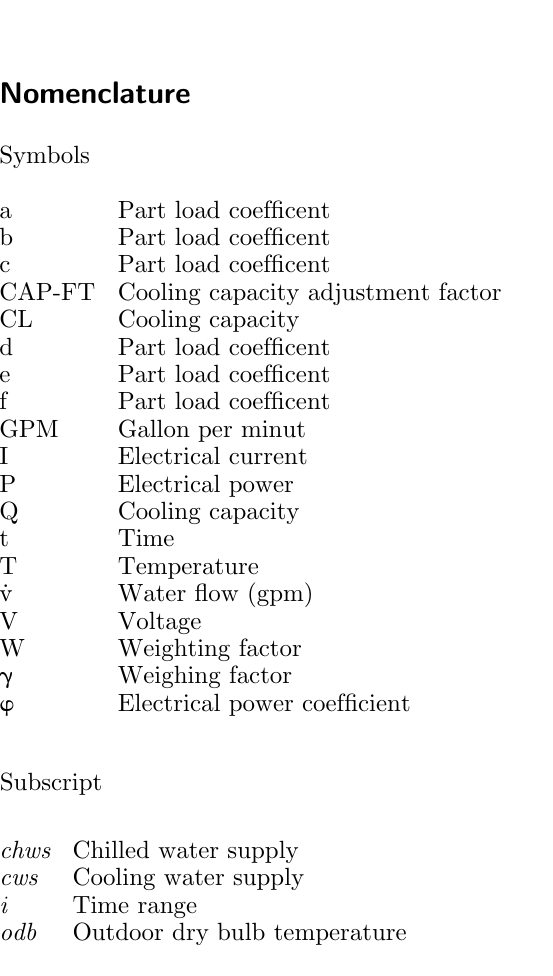
Fig. 12. Cooling load natural gas consumption for single effect absorption